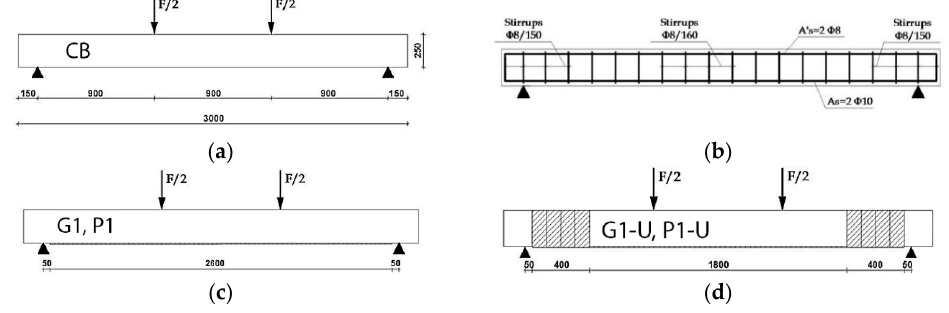
Figure 1. Prototypes: ( a ) Geometry of the control beam (CB); ( b ) Internal steel reinforcement; ( c ) Beams G1, P1; ( d ) Beams G1-U,